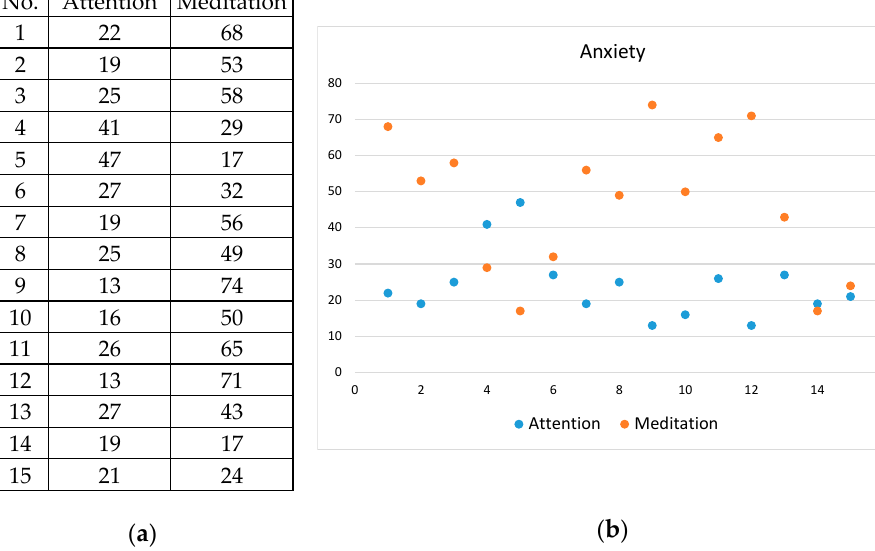
Figure A4. The data and the distribution graph of the average values of the 15 measured two-feature sample sequences of the emotion type of anxiety, from which the corresponding decision rule a < 30 or m < 30 for emotion classification was inferred, where m and a represent the meditation and attention signals, respectively. ( a ) The average data. ( b ) The distribution graph.